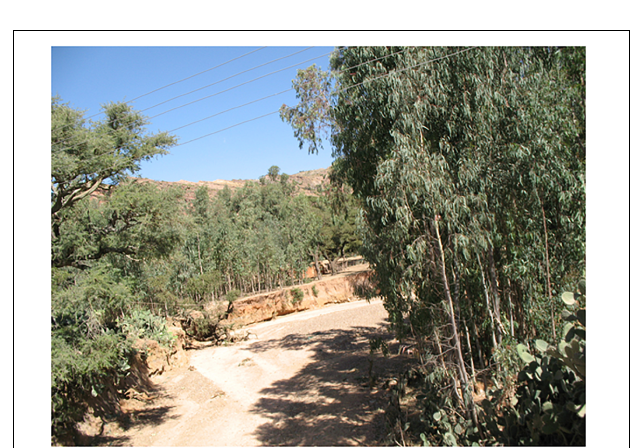
FIGURE 2 | Afforestation in the Tigray region of Ethiopia. As in other parts of the country, most such efforts are devoted to Eucalyptus sp . of Australian origin which is used in construction, cooking, and other applications. Groves are located in the countryside, on the edges of towns, and even on small plots within cities. Photo: Gad